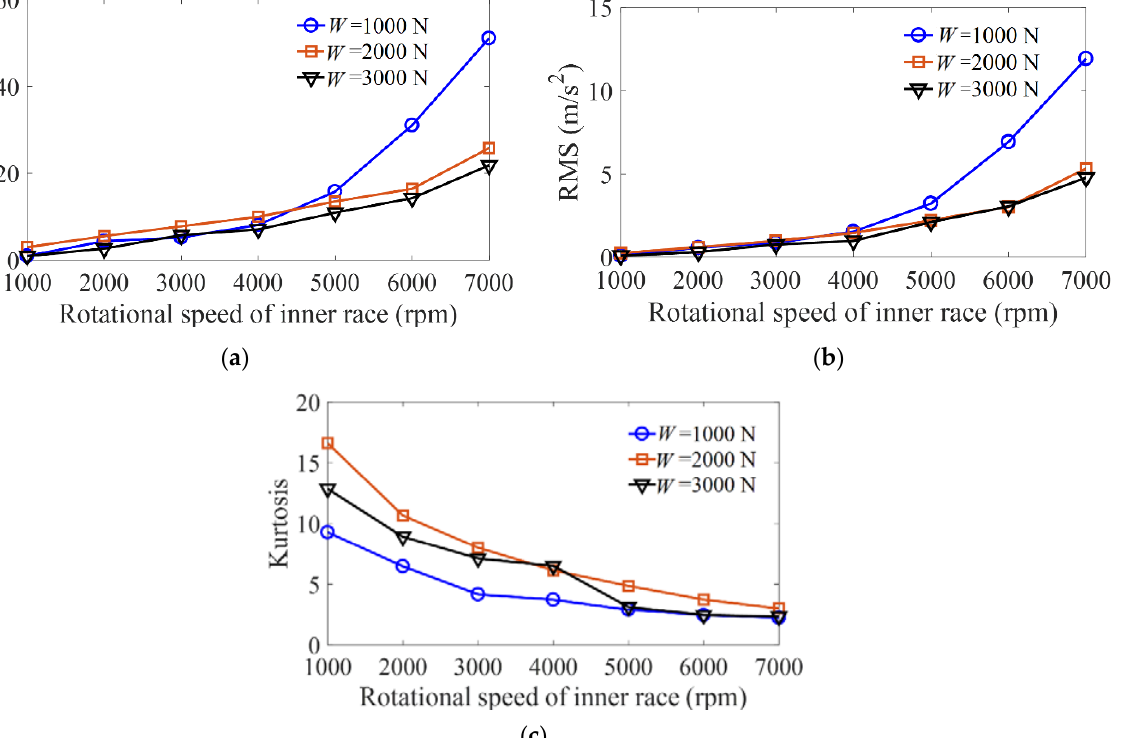
Figure 13. Effect of rotational speed on statistical indicators of the acceleration of the inner raceway under different radial loads W ( s c = 2%, μ m = 0.01): ( a ) PTP value; ( b ) RMS value; ( c ) kurtosis value.